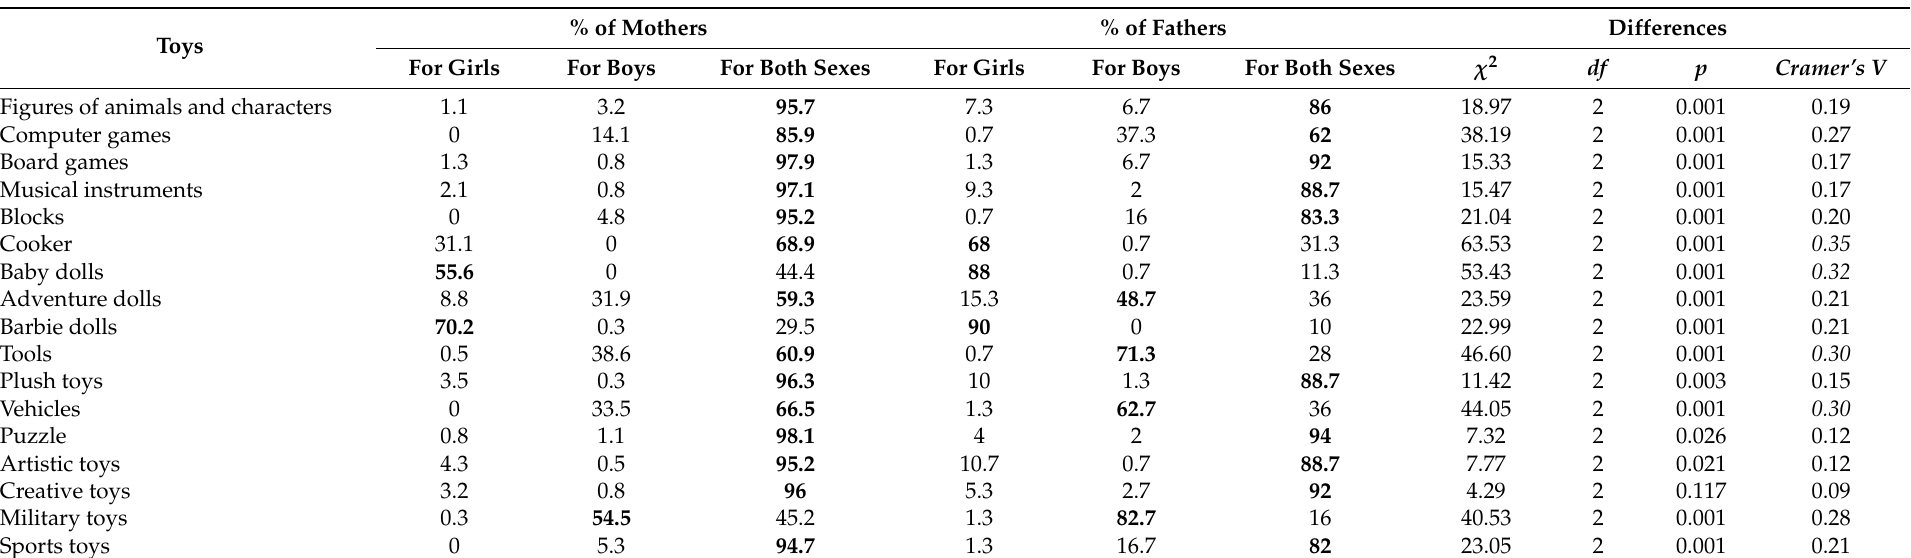
Table 7. Perception of toys’ appropriateness according to children’s gender—parents’